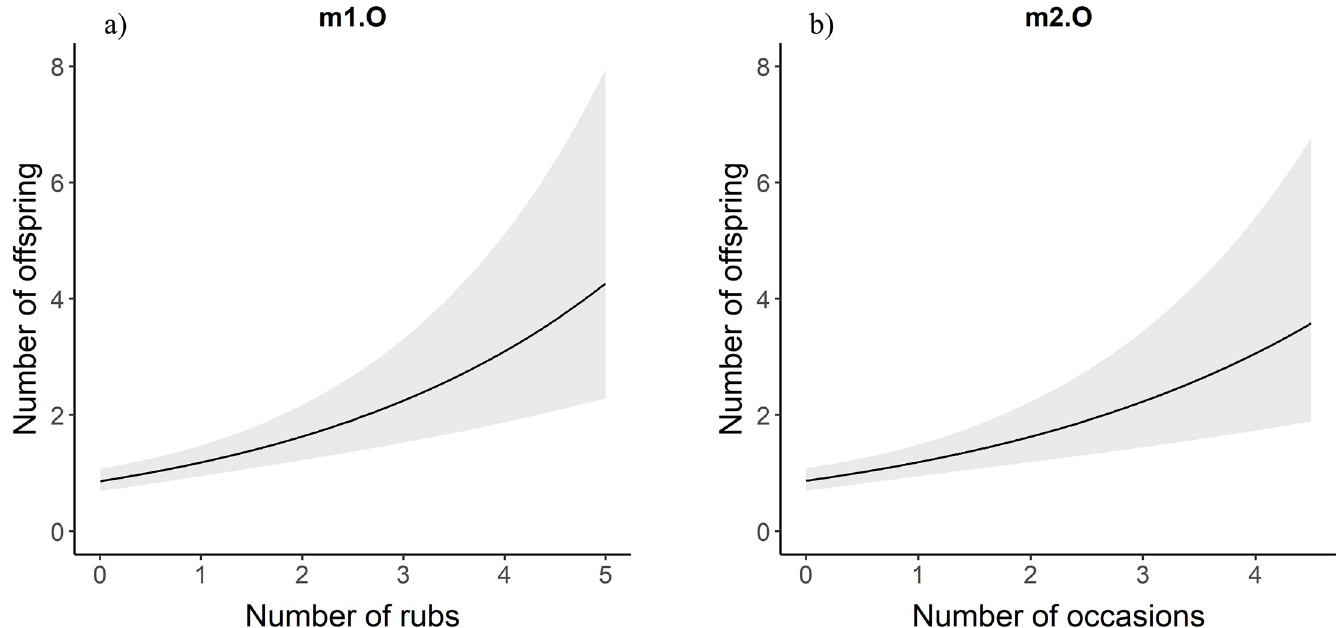
Fig 4. m1.O and m2.O. Poisson regression response curves showing the relationship between the number of offspring a male brown bear had and the number of rub objects (a) at which and sampling occasions (b) during which it was detected. Confidence intervals are in grey. Data are from southwestern Alberta